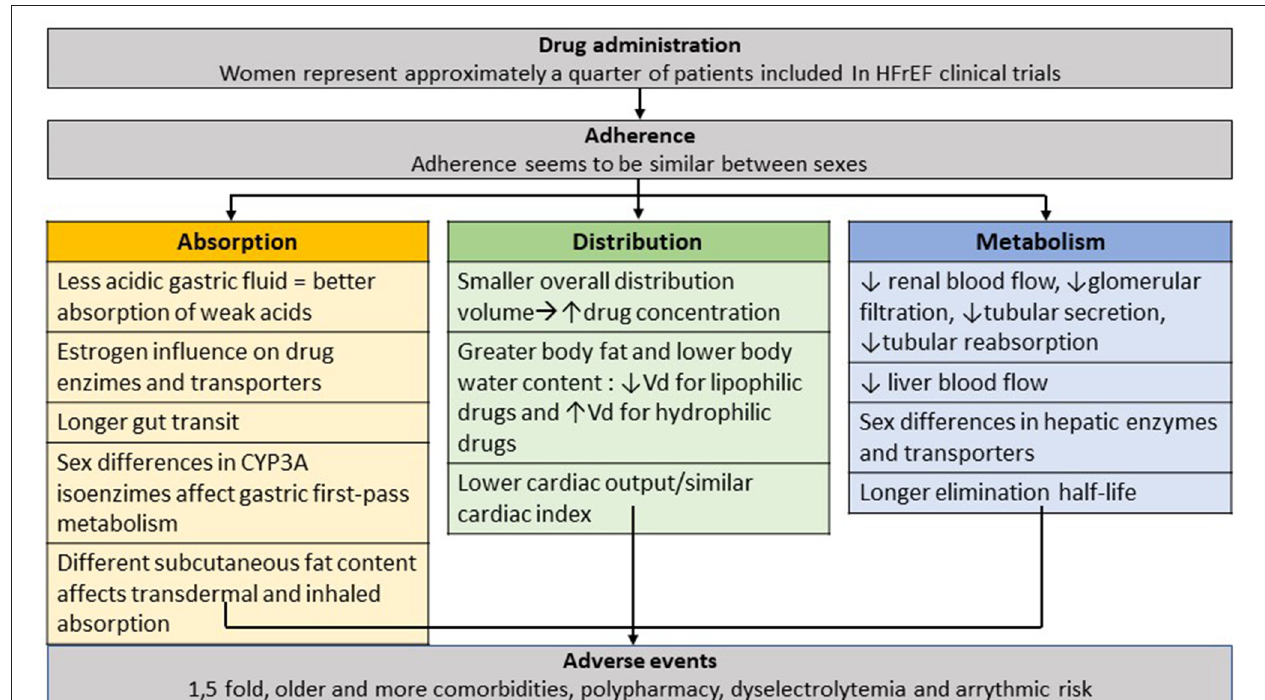
FIGURE 3 | Use of heart failure drugs in women. Sex-differences on prescription, adherence, effective circulation levels and adverse events. HFrEF, Heart Failure reduced Ejection